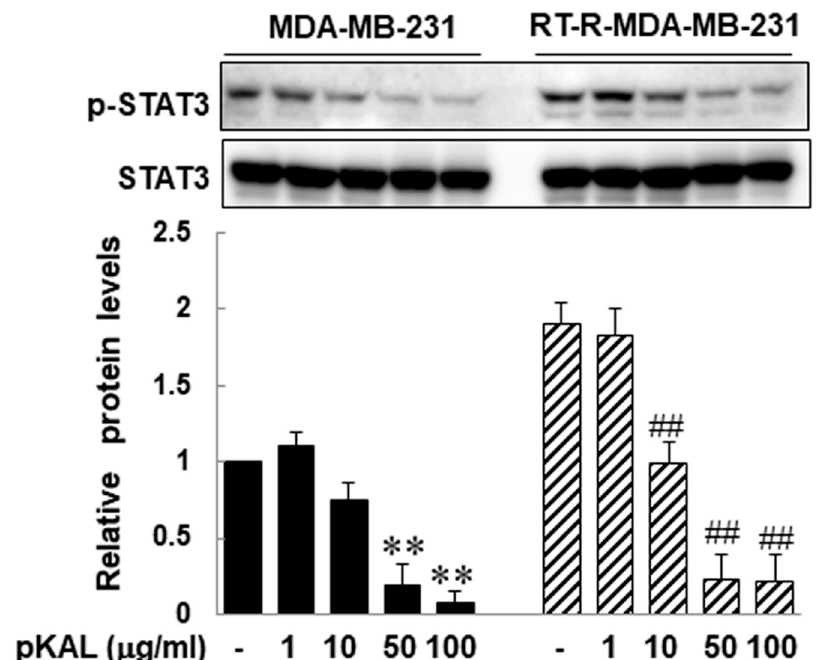
Figure 3. Inhibitory e ff ects of pKAL on STAT3 phosphorylation of both parental and RT-R-MDA-MB-231 cells. The cells were treated with indicated concentrations of pKAL for 24 h. The expressions of p -STAT3 and STAT3 proteins were measured by western blot analysis. The band density was measured by densitometry, and the values are expressed as the means ± SEM from three independent determinations (** p < 0.01 vs. control for parental MDA-MB-231 cells, and ## p < 0.01 vs. control for RT-R-MDA-MB-231 cells).